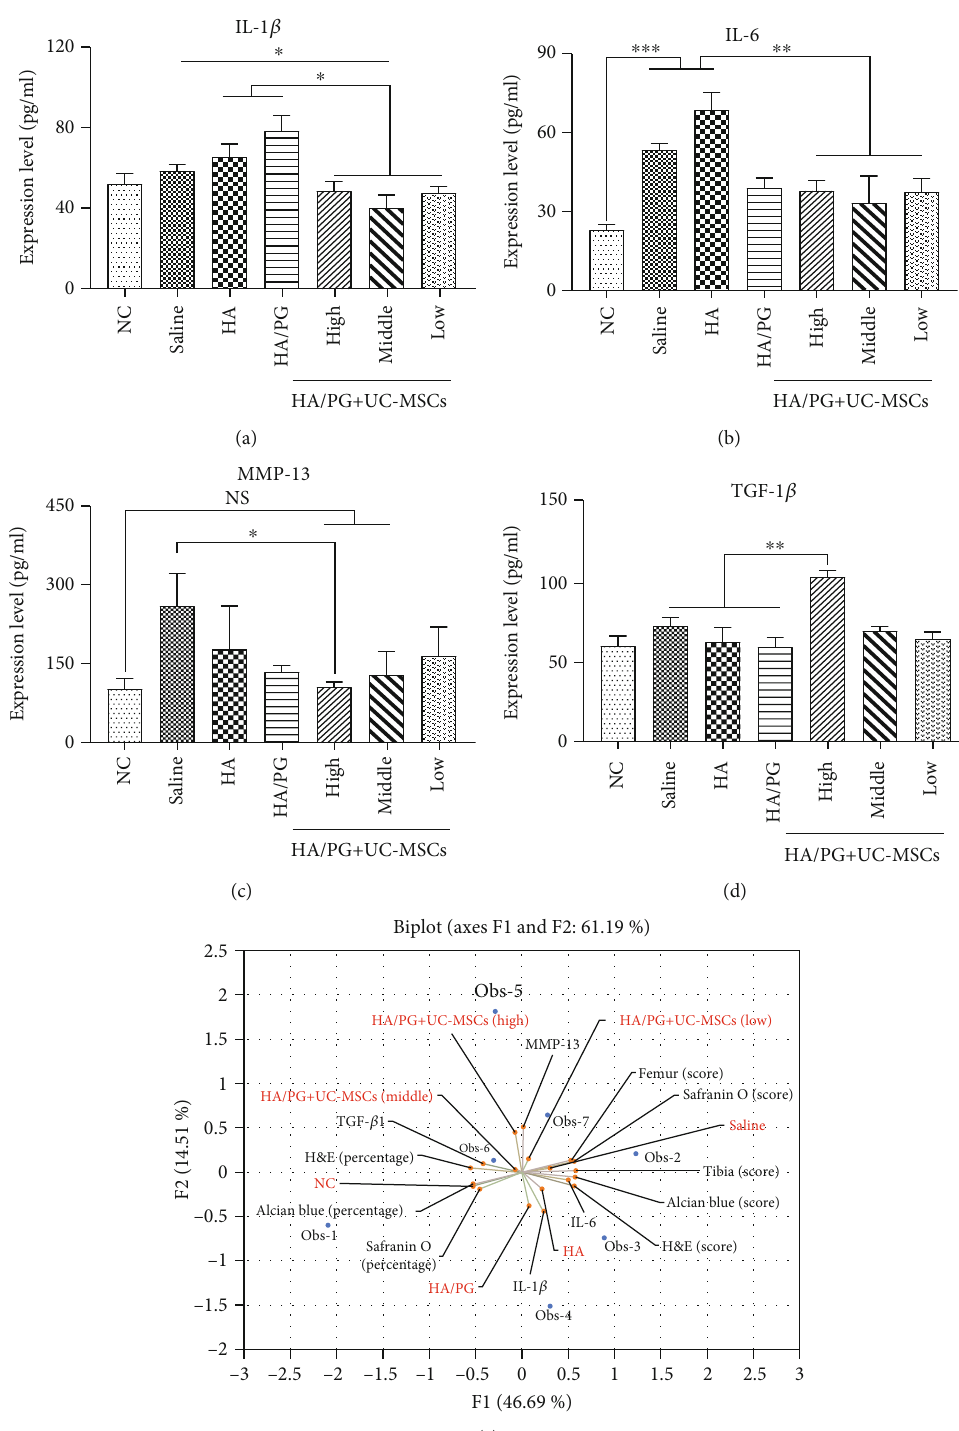
Figure 4: Expressions of proin fl ammatory cytokines in joint fl uid and systematic assessment of OA rabbits. (a – d) Statistical analysis of the expression levels of proin fl ammatory factors in synovial fl uid in the indicated 7 groups by ELISA including IL-1 β (a), IL-6 (b), MMP-13 (c), and TGF-1 β (d). Data were shown as mean ± SD ( n = 8 ). ∗ P < 0 : 05 ; ∗∗ P < 0 : 01 ; ∗∗∗ P < 0 : 001 ; NS: not signi fi cant. (e) Principal component analysis (PCA) of the aforementioned 19 parameters involved in the MIA-induced OA rabbit model among the indicated 7 groups. F1 and F2 represented principal components 1 and 2 (PC-1 and PC-2),